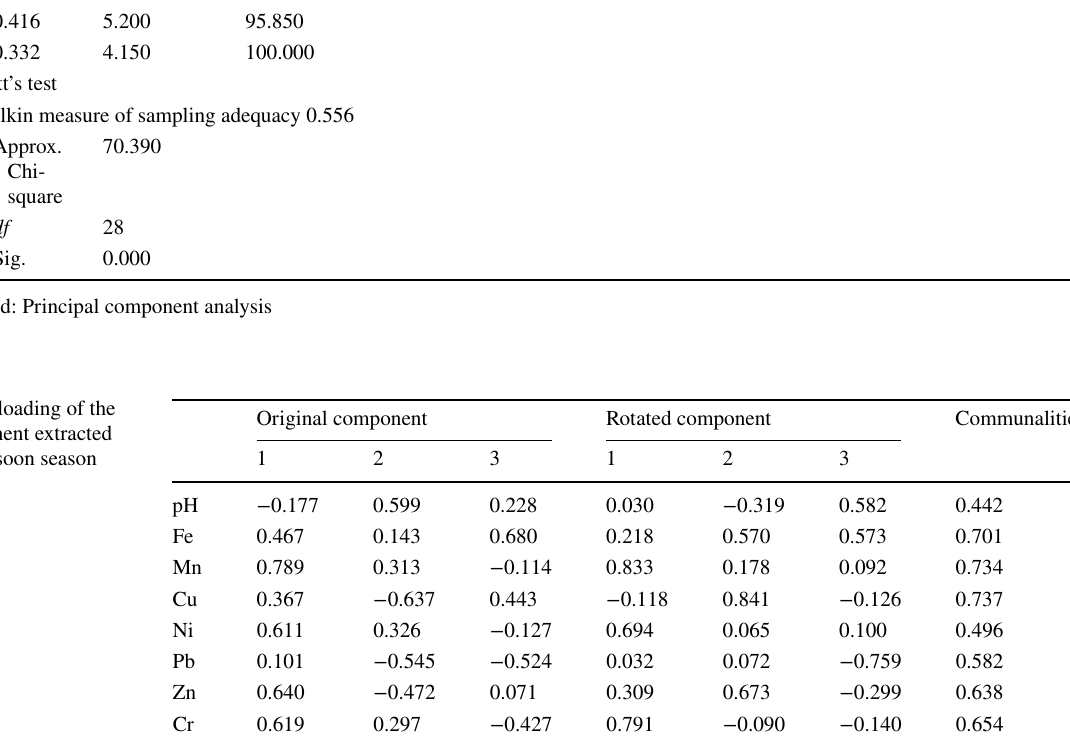
Extraction method: Principal component analysis. Three